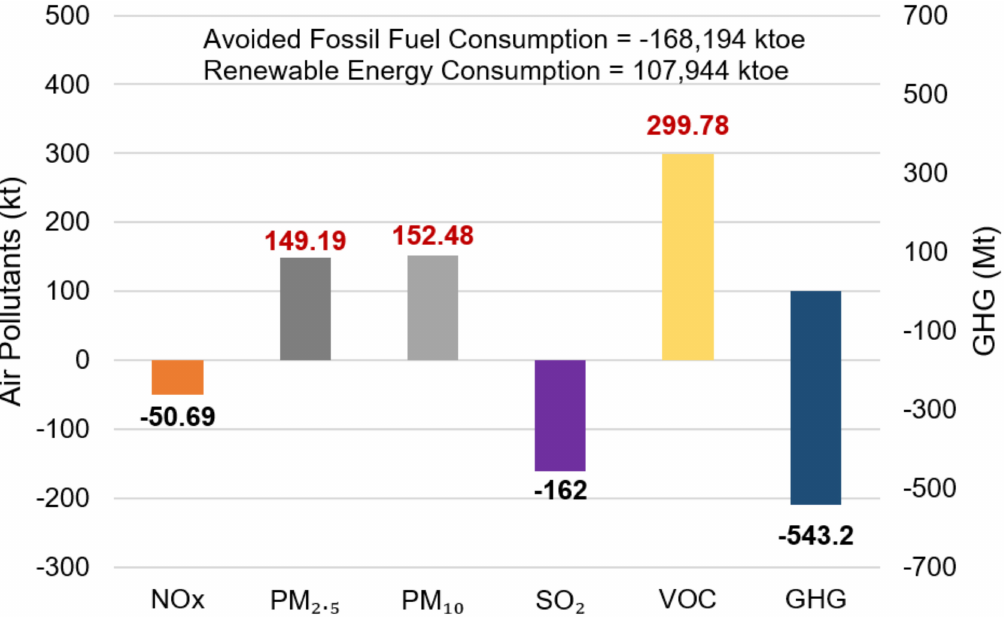
Figure 1. The changes in GHG and air pollutant performance with an increasing share of renewable energy (comparison between 2005 and 2018). Data extracted from [19]. Table 2. The levelized energy cost of di ff erent sources. a The considered subsidies are based on US federal tax subsidies which can vary from country to country. b Biomass is based on the analysis